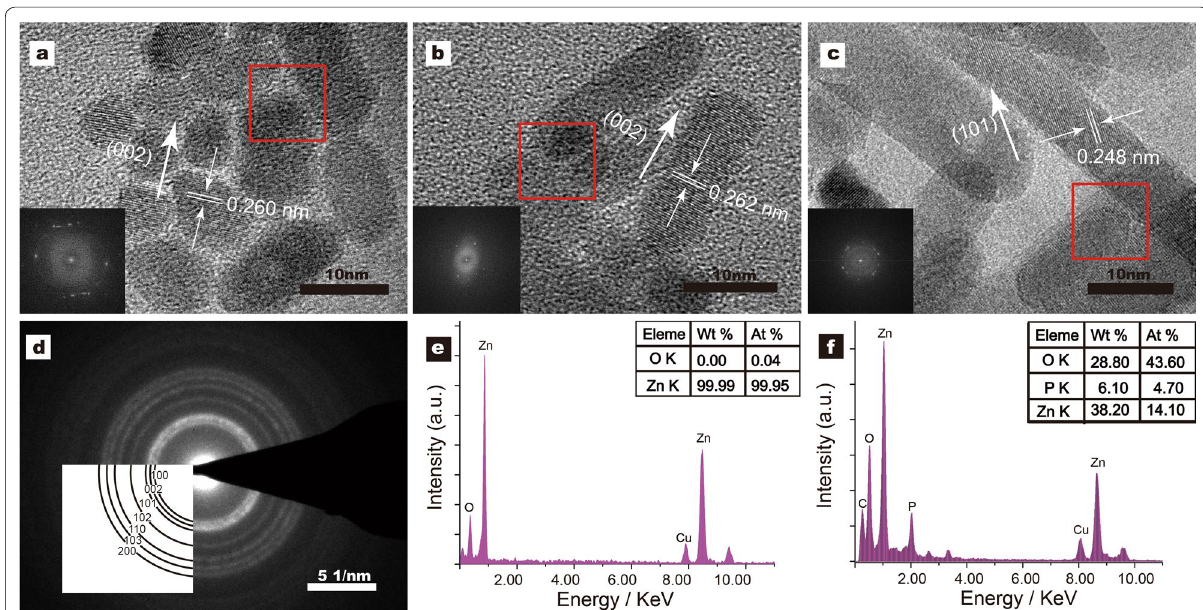
Fig. 2 The characterization of ZnO NPs structure ( a – c ). The HRTEM images of Pristine ZnO NPs (~ 7 nm; ~ 18 nm; ~ 49 nm). The inserted photos show the Fourier filtered image from the red box. d The SAED pattern shows a wurtzite pattern from sample ZnO NPs (~ 7 nm). e The EDX spectrum results from sample ZnO NPs (~ 7 nm), and f Lipid-coated ZnO NPs (~ 13